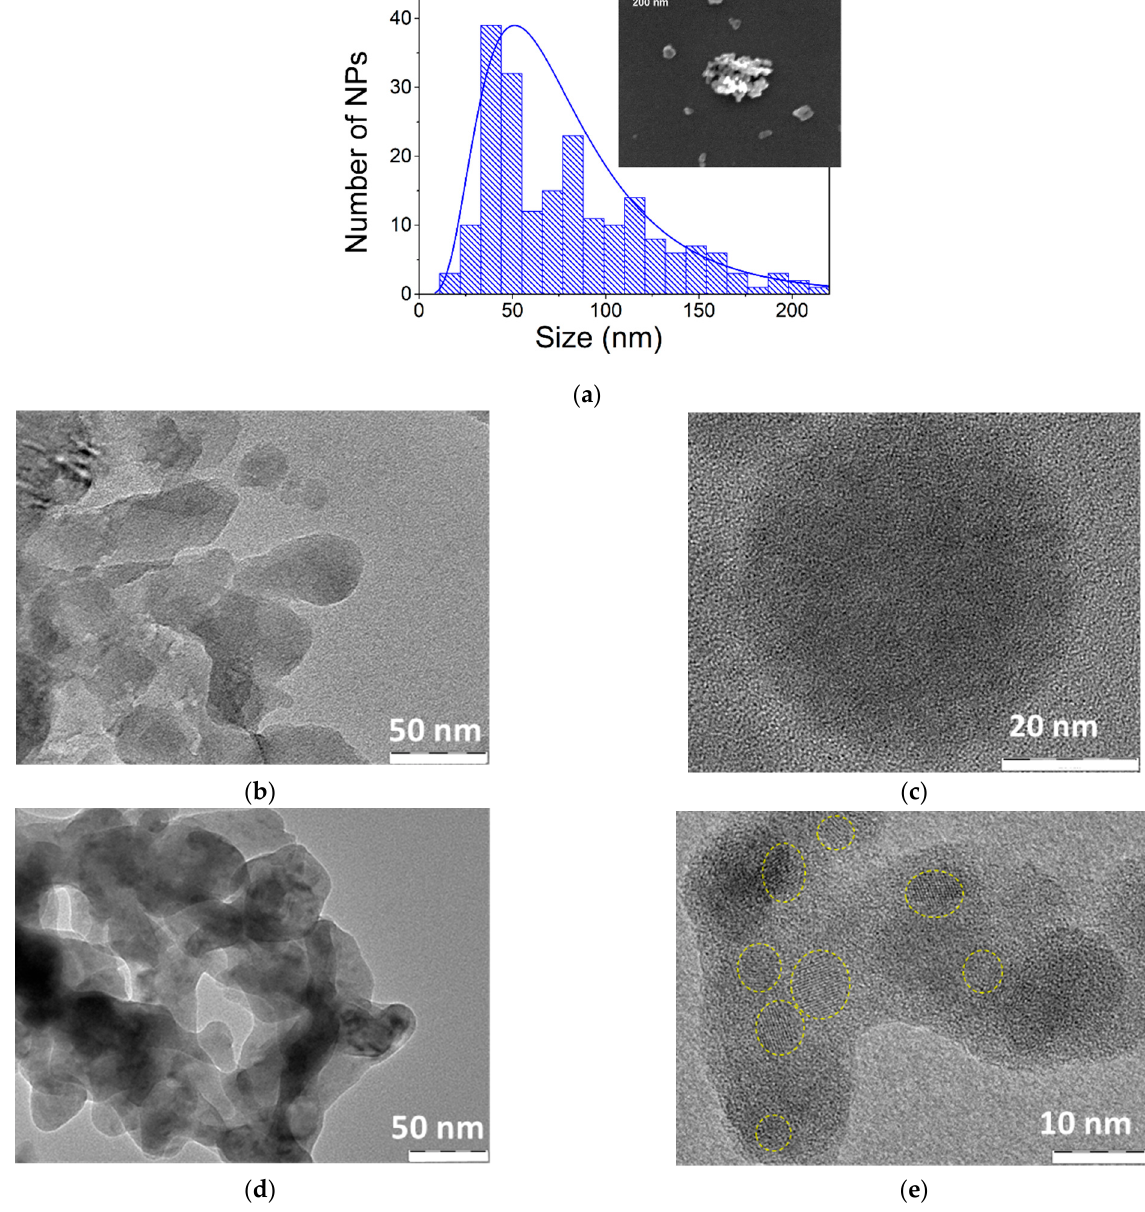
Figure 2. ( a ) Typical SEM image and corresponding size distribution of Ge NPs obtained by grinding of laser-ablated Ge nanostructured films (sample Ge2.5/2.5 NPs) and dispersed in ethanol after the centrifugation. The size distribution was calculated using a neural network analysis [47]. Typical TEM images of Ge NPs obtained by grinding of Ge nanostructured films and dispersed in ethanol: sample Ge 5.0 NPs ( b , c ) Ge2.5/2.5 NPs ( d , e ). Yellow dashed circles in panel ( e ) highlight locations of Ge nanocrystals.